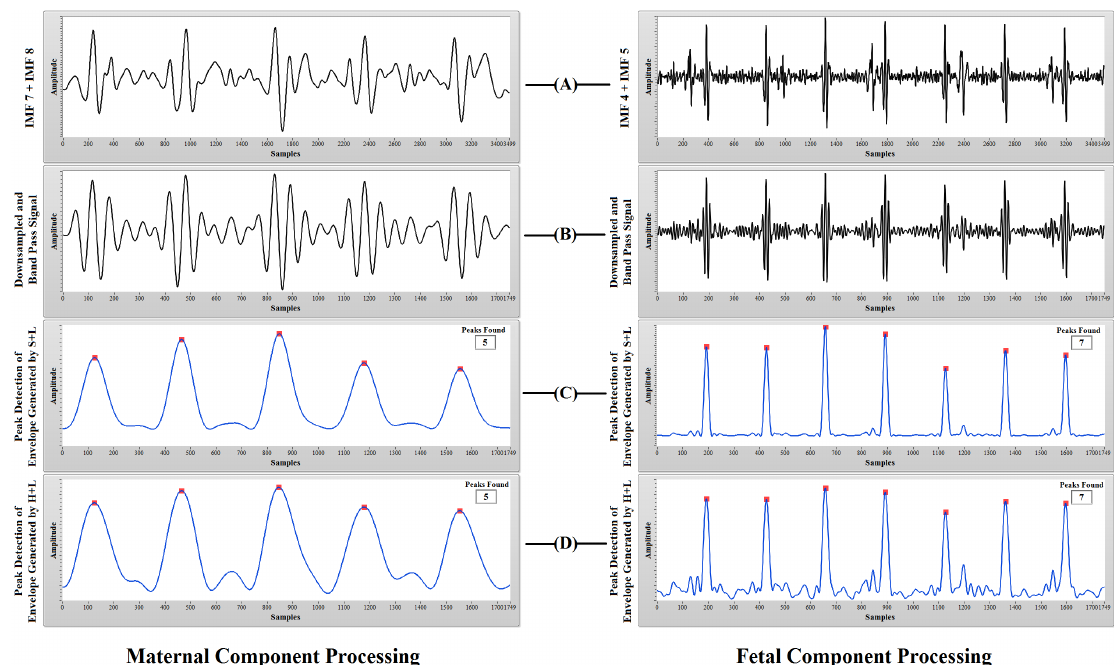
Figure 8. PhysioNet aECG processing: ( A ) sum of the selected IMFs for probable MHR and FHR information; ( B ) downsampled and bandpass signal; ( C ) peak detection of the envelope generated using squaring and low-pass filtering (S+L); ( D ) peak detection of the envelope generated using Hilbert transform and low-pass filtering (H+L).